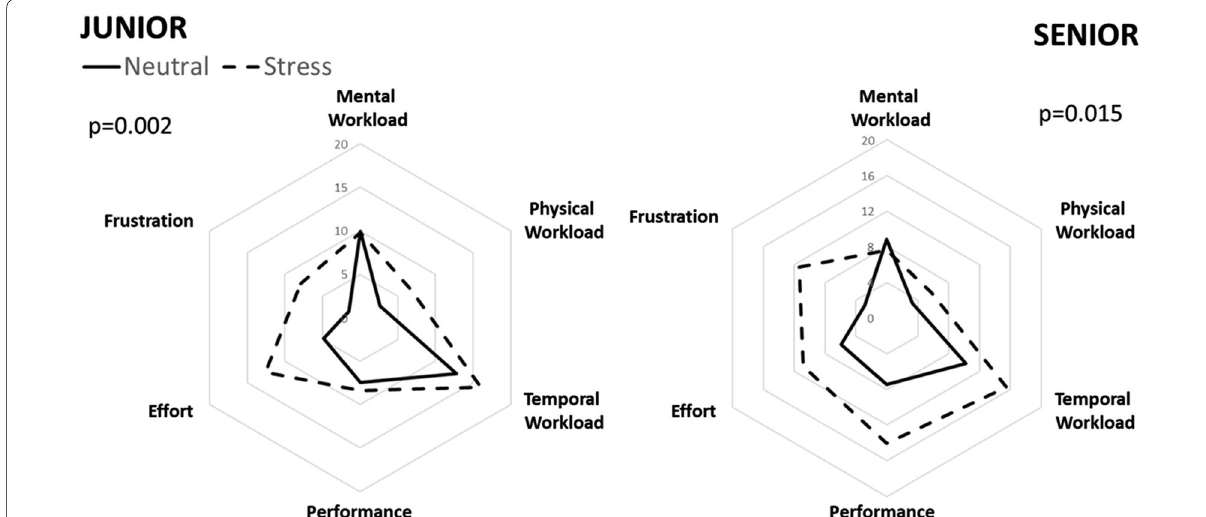
Fig. 2 NASA-TLX dimension assessment. Left graph represents juniors’ assessment, and right graph senior’s assessment. Plain line represents measurements during neutral scenario, and dotted line measurements during stress scenario. p value compared NASA-TLX between each scenarios and for each group. There was a difference of NASA-TLX between neutral and stress scenario for juniors (38.5 seniors (39.2 15.7 vs. 61.3 12.9; p ± ± =